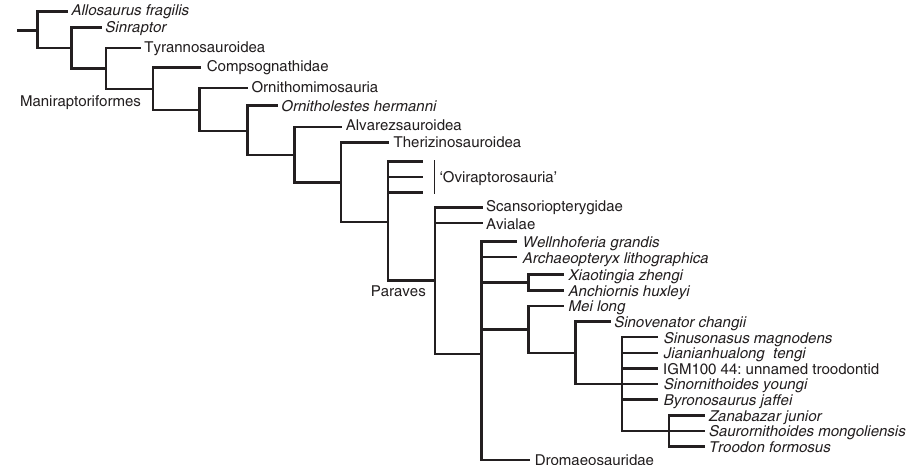
Figure 6 | Strict consensus of 3,066 most parsimonious trees produced by phylogenetic analysis. The strict consensus tree (tree length ¼ 1,426, CI ¼ 0.279) shows the systematic position of Jianianhualong tengi among the